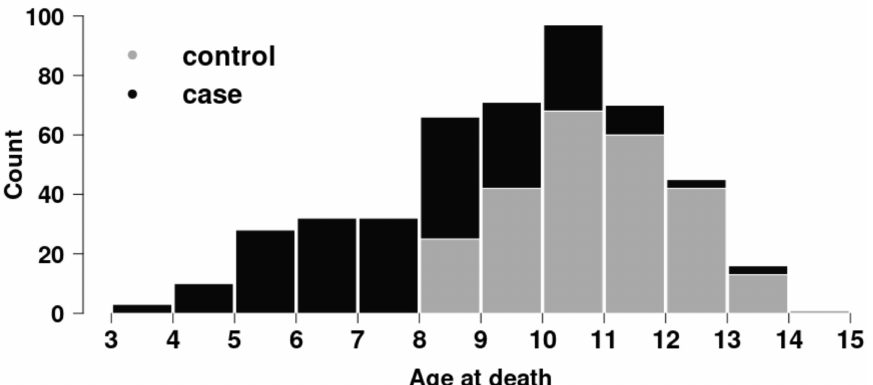
Figure 1. Distribution of age at death in 220 OSA-affected cases and 251 OSA-unaffected controls in Leonbergers.